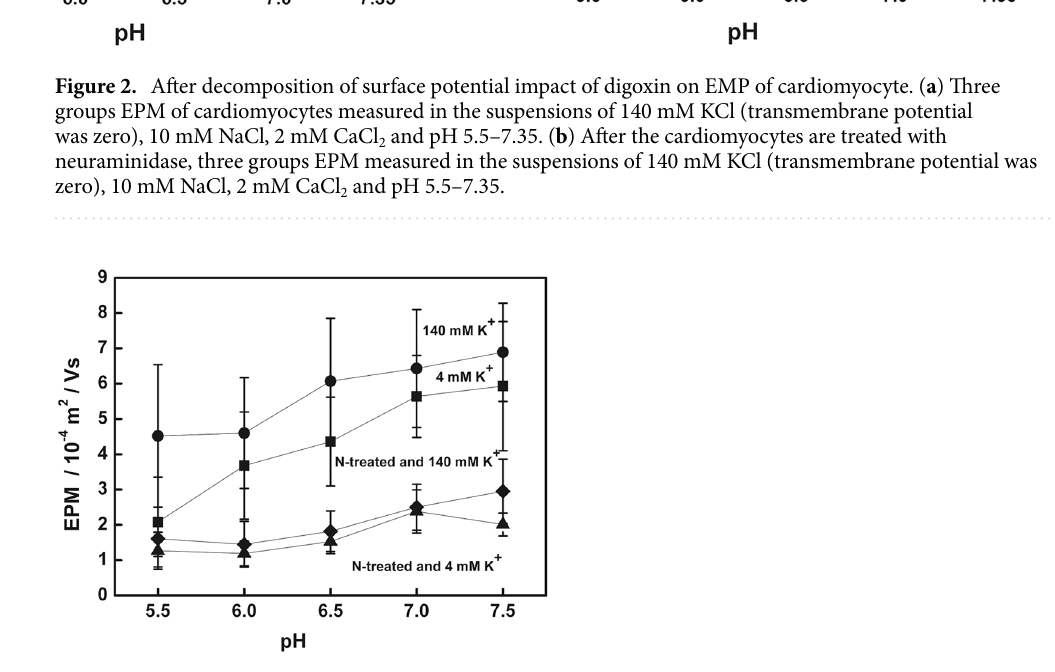
Figure 3. Impact of cellular surface potential components for the EPM of cardiomyocyte. 4 mM K + : Suspension in 145 mM NaCl, 2 mM CaCl 2 , 4 mM KCl and pH 5.5–7.35. 140 mM K + : Suspensions in 140 mM KCl (transmembrane potential was zero), 10 mM NaCl, 2 mM CaCl 2 and pH 5.5–7.35. N-treated and 4 mM K + : After treatment with neuraminidase, suspensions in 145 mM NaCl, 2 mM CaCl 2 , 4 mM KCl and pH 5.5–7.35. N-treated and 140 mMK + : After treatment with neuraminidase, and suspensions in 140 mM KCl (transmembrane potential was zero), 10 mMNaCl, 2 mM CaCl 2 and pH